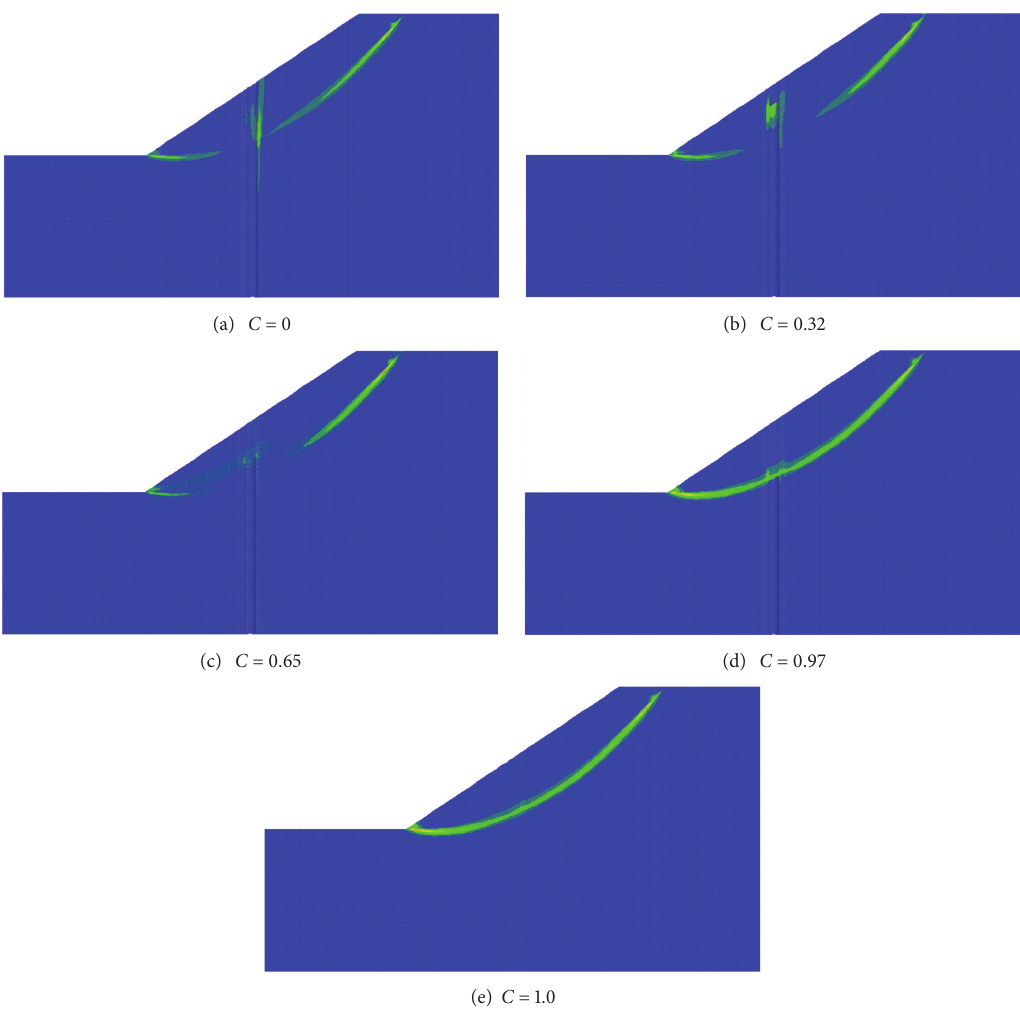
Figure 21: Failure mode of piled slopes for Model B (at 𝑦 = 0